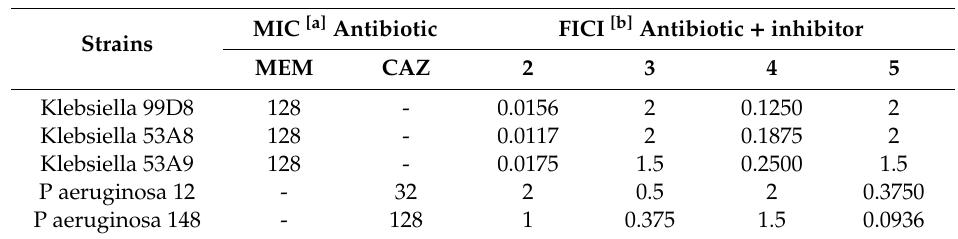
Table 2. In vitro interaction between antibiotics and boronic compounds determined by fractional inhibitory concentration index